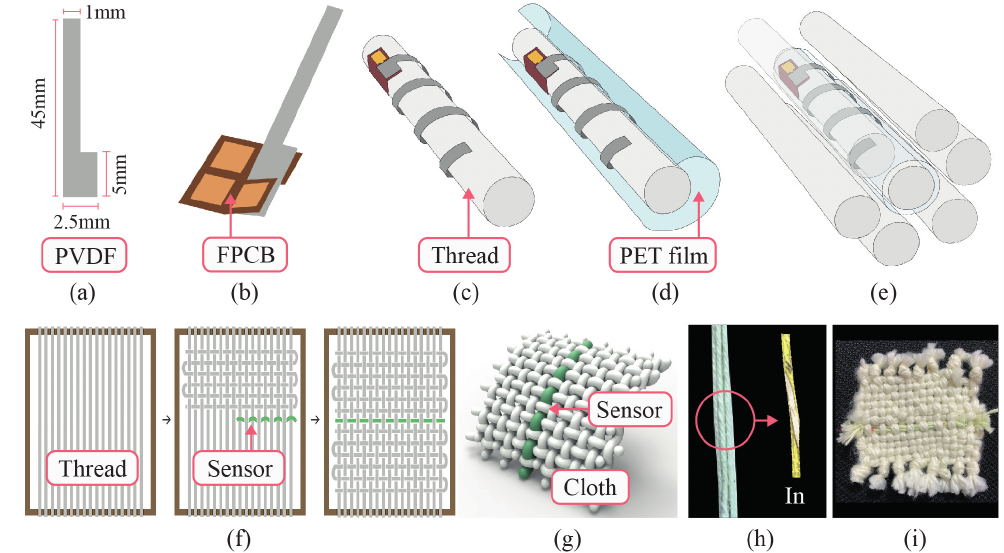
Figure 2. Fabrication process of the sensor. ( a ) PVDF film cut in an ax shape, ( b ) FPCB electrode attached to the PVDF film, ( c ) PVDF film curled around a thread with a helical structure, ( d ) sensor coated with a PET film tape, ( e ) sensor covered by six threads, ( f ) sensor woven by a weaving kit, ( g ) schematic